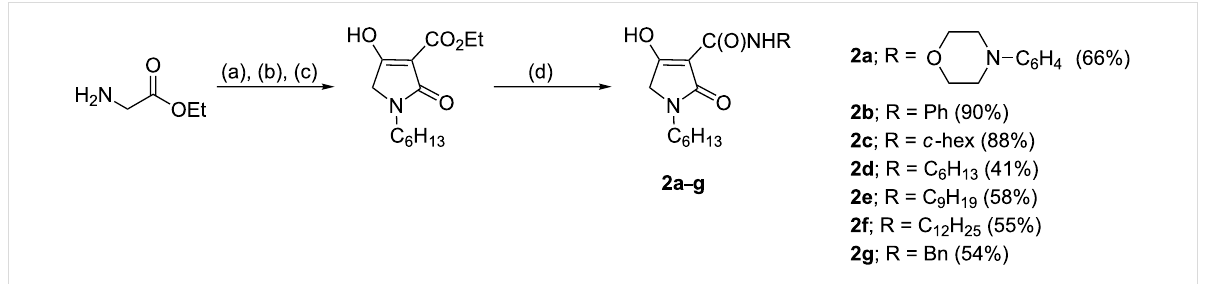
Figure 1: Some antibiotic natural and unnatural tetramic